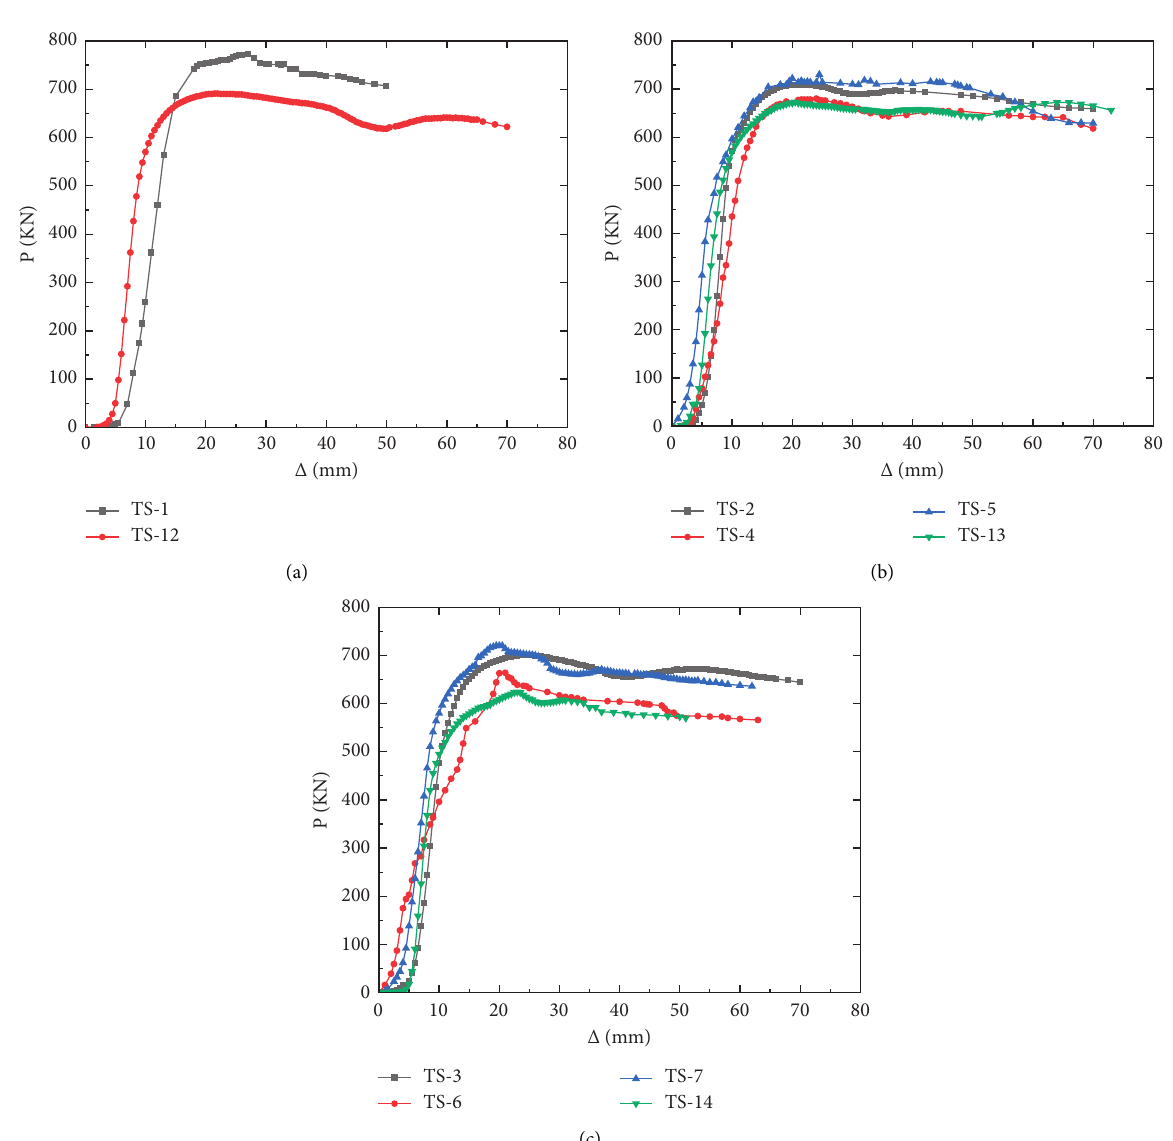
Figure 6: Load-displacement curve with different SF